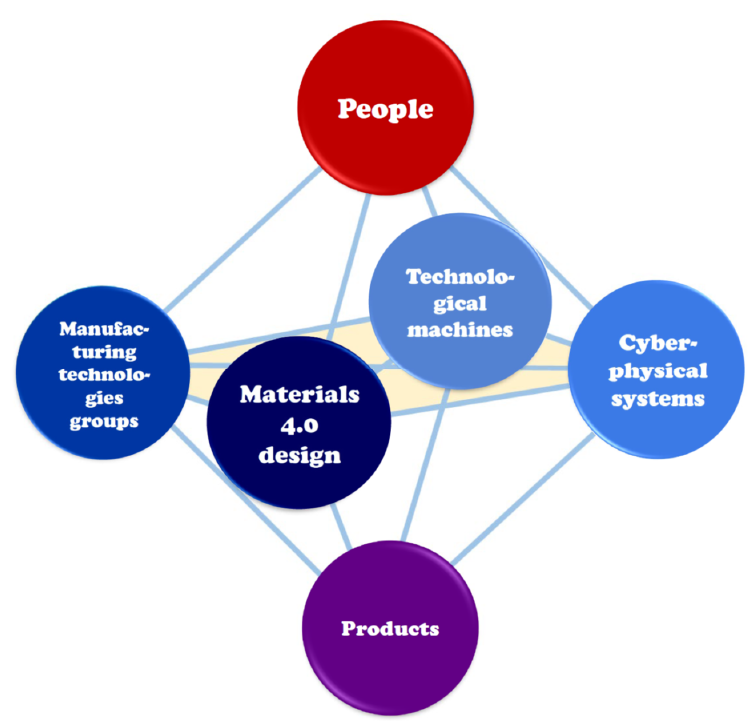
Figure 6. Octahedron of the extended holistic Industry 4.0 model containing four complementary components in the technological plane.